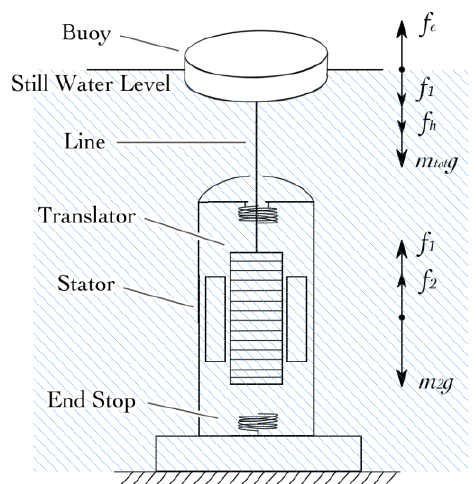
Figure 1. A basic mechanical structure of the studied wave energy converter (WEC) device showing the force diagram on the right side of the WEC.